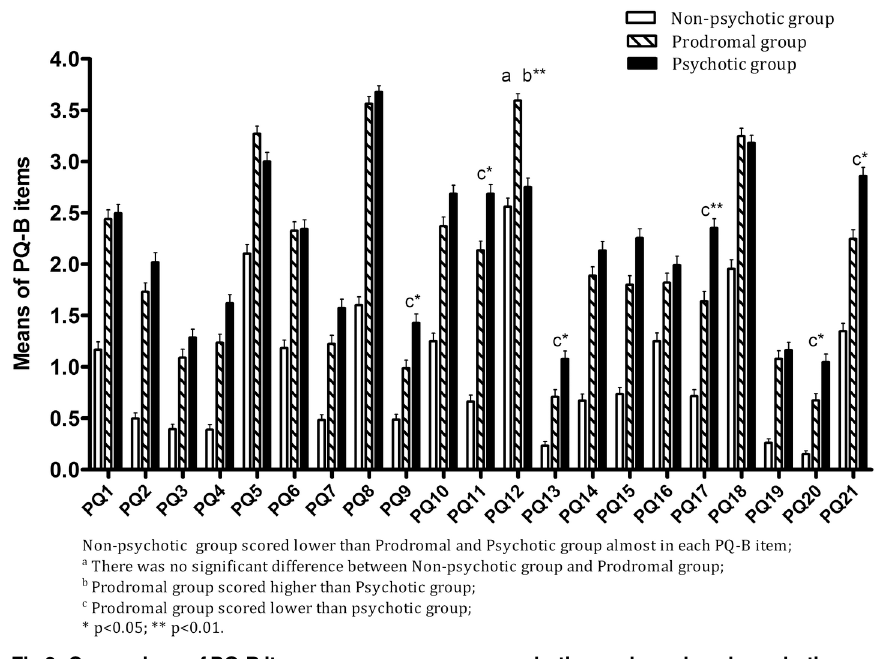
Fig 2. Comparison of PQ-B item scores among non-psychotic, prodromal, and psychotic groups.